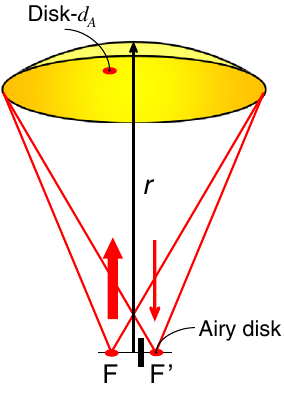
FIG. 1. Coherent scattering by separated biomolecules in an aqueous medium. The molecules are assumed to be localized randomly in a thin layer with thickness t part of an ellipsoid of revolution that has two optically conjugated foci F and F 0